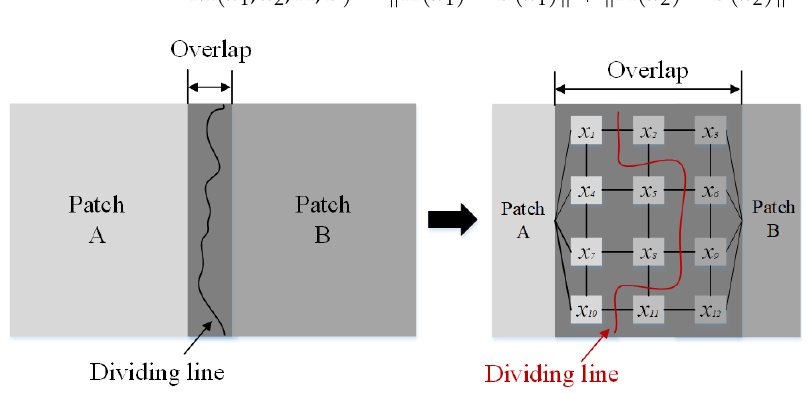
Figure 7. Graphcut method for image cu tt ing.